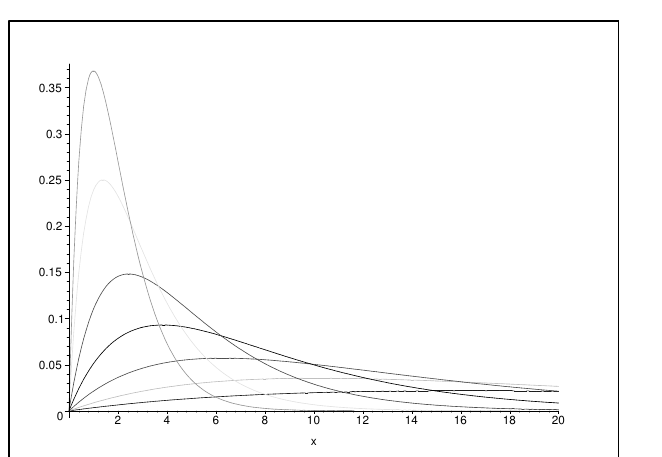
( x ) , n = 2,3,4,5,6,7,8, given in X n